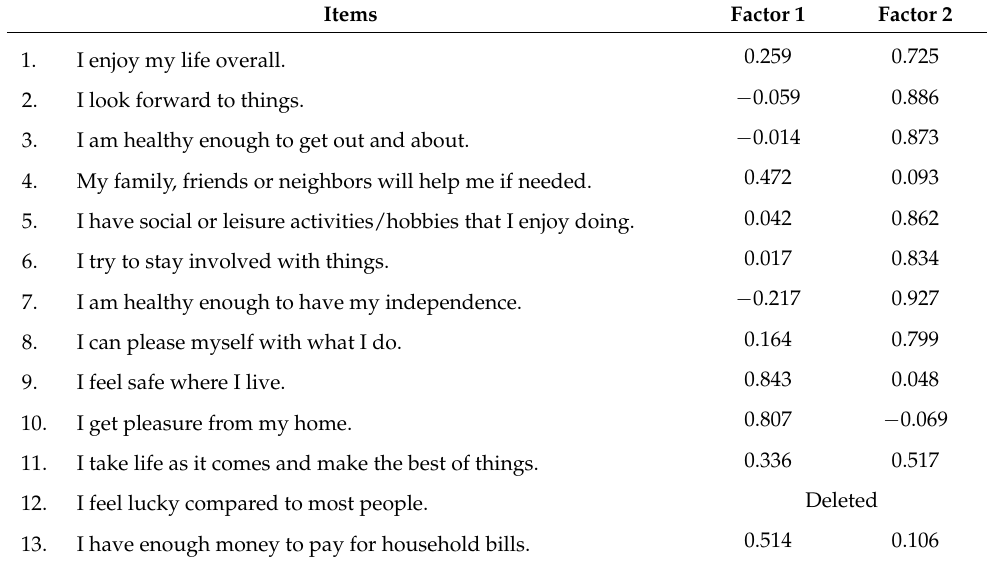
Table 2. Rotated loading matrix.